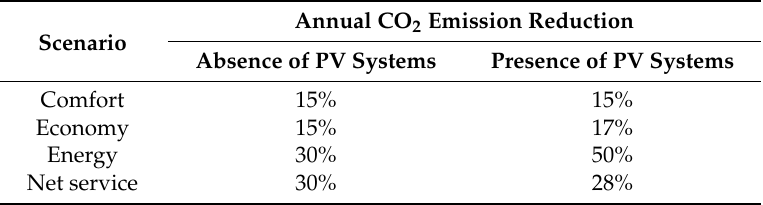
Table 12. Turin—CO 2 emission reduction with respect to the traditional scenario (S.0).